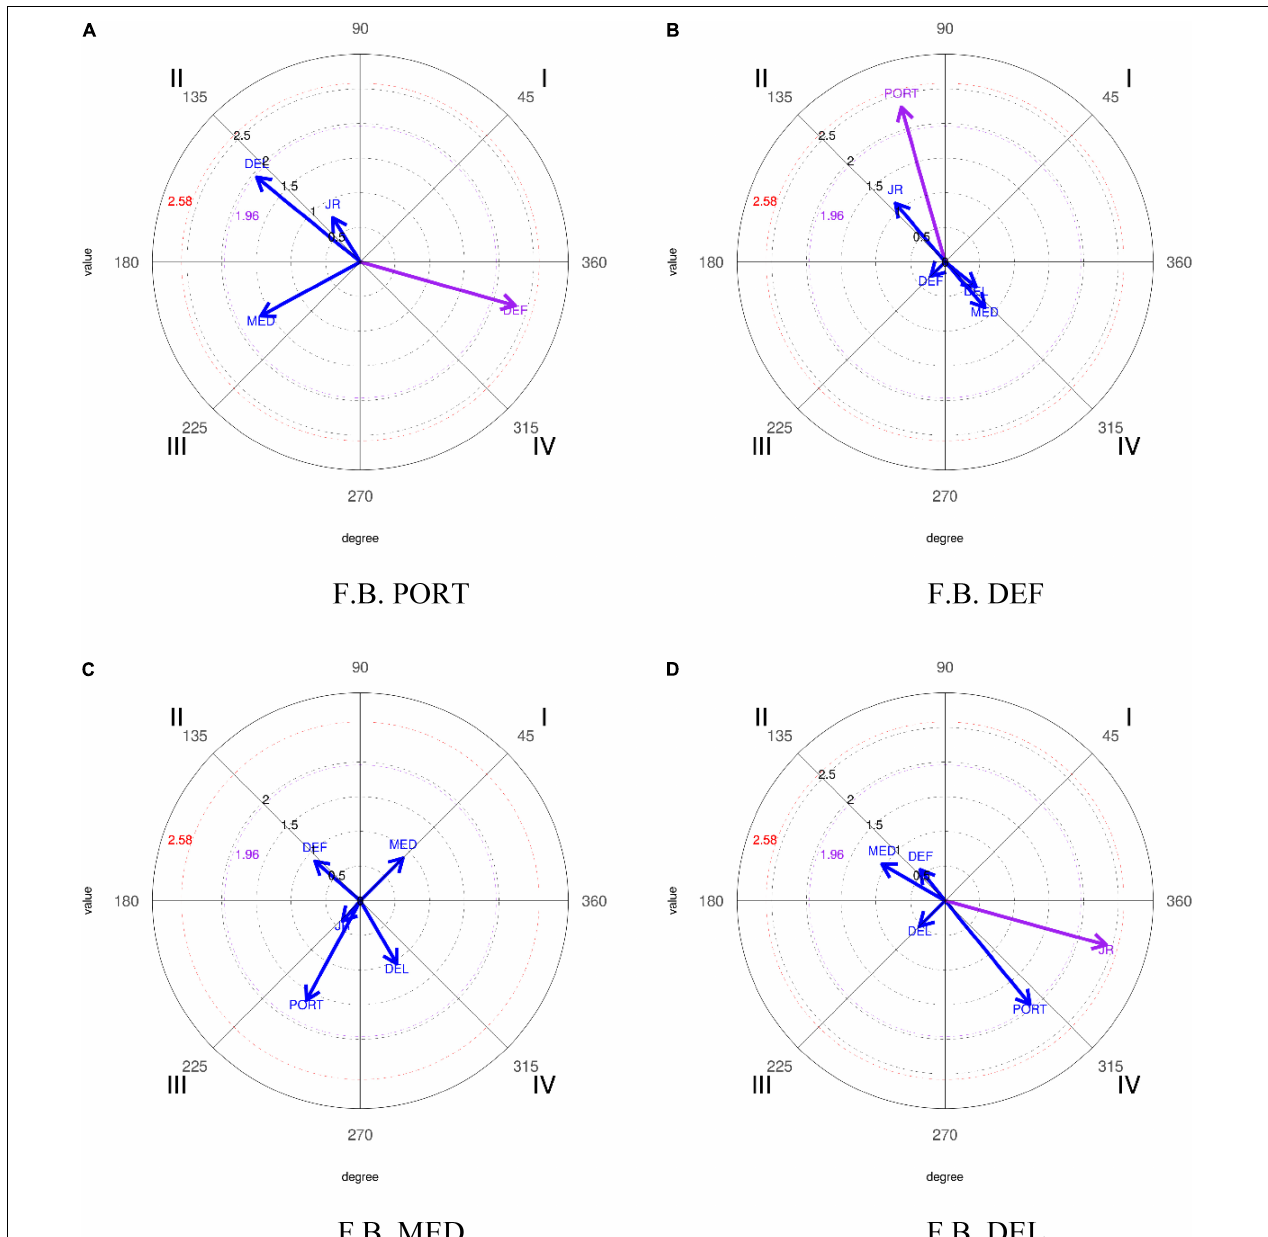
FIGURE 3 | Representation of the behavioral maps establishing the different categories as focal behavior, in relation to the lines that structure the team for the 2016–2017 season. *FB, focal